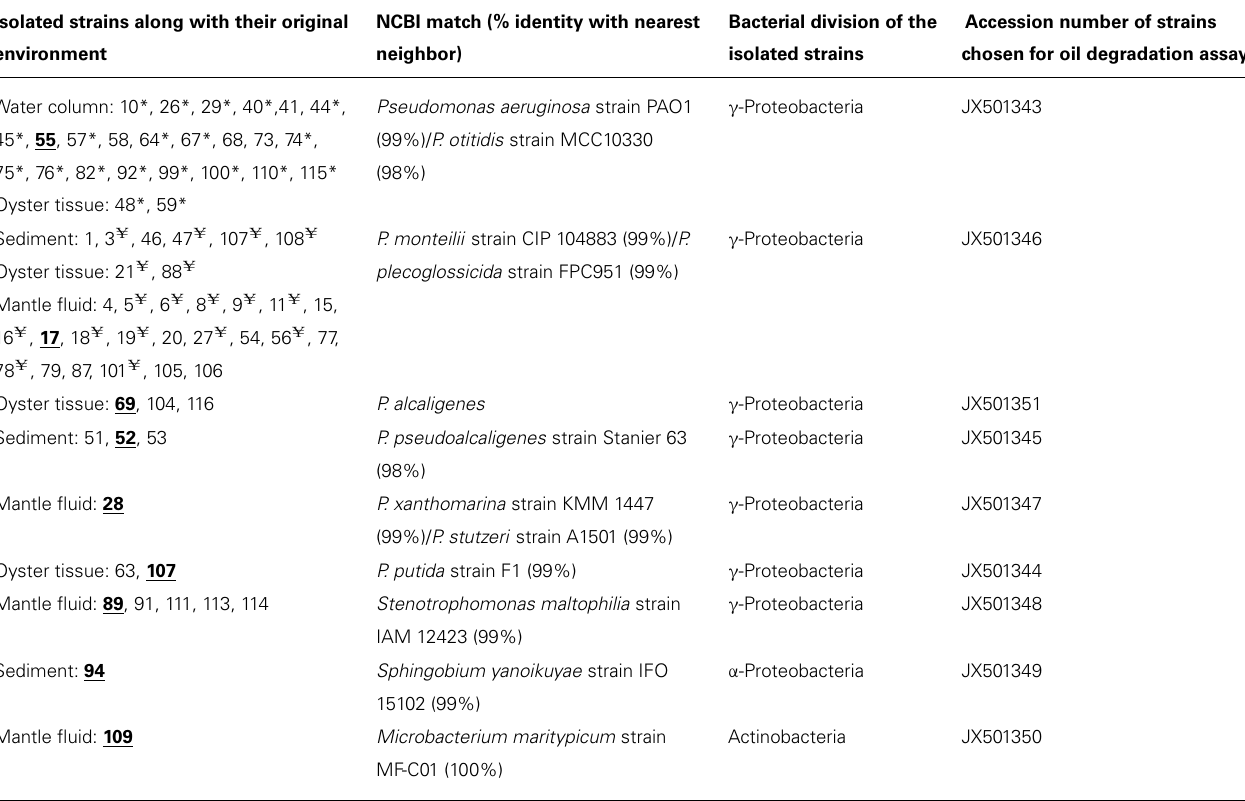
Table 1 | Summary of oil-degrading bacterial strains isolated from DWH oil-amended microcosms containing oyster tissue (OT), mantle fluid (MF), water column (WC), and sediment (S) samples obtained from Dry Bar,Apalachicola Bay, FL, USA. Isolated strains along with their original NCBI match (% identity with nearest Bacterial division of the Accession number of strains environment neighbor) isolated strains chosen for oil degradation assay Pseudomonas aeruginosa strain PAO1 γ -Proteobacteria JX501343